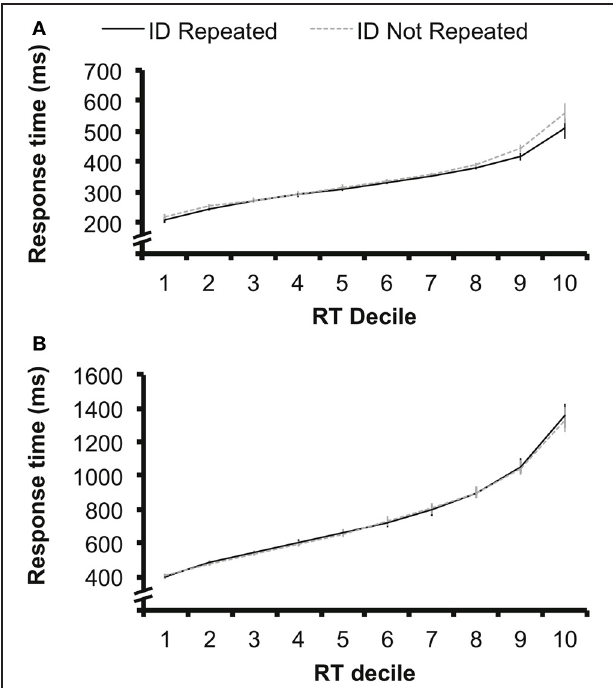
FIGURE 5 | (A) Data from the singleton-target condition of Experiment 1 sorted into response time deciles for the target identity repeated (ID Repeated) and target identity not repeated (ID Not Repeated), with the fastest 10% of responses in each condition in Decile 1, and the slowest 10% of responses in Decile 10. The magnitude of the priming benefit did not diminish in slower responses; instead, target identity repetition benefits were larger in magnitude in later deciles in which response times were slower. Error bars represent 95% confidence interval calculated separately for each decile (e.g., Loftus and Masson, 1994). (B) The same analysis applied to the data from Experiment 2. Target identity repetition benefits are not observed at any decile. Error bars represent 95% confidence interval calculated separately for each decile (e.g., Loftus and Masson,